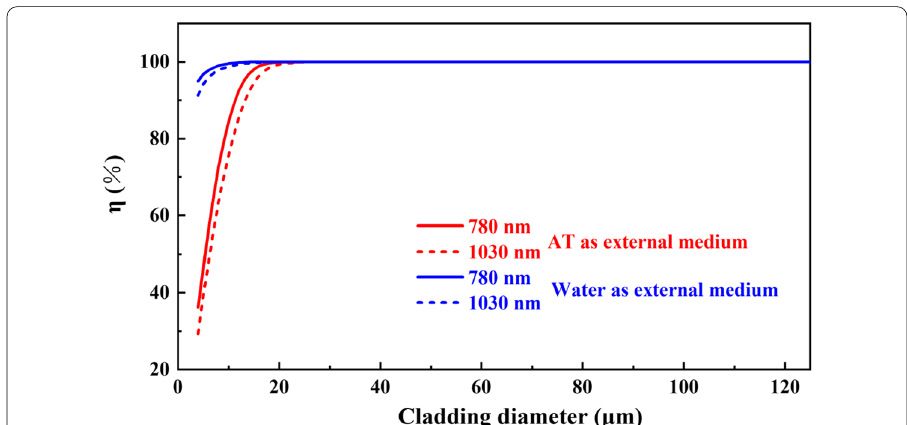
Fig.4 The calculated results of the fraction of optical power in the fiber η with 4 μm to125 μm cladding diameters. The blue line denotes that the external medium is water, and the red line denotes that the external medium is ATs. The η is 92.4% at 780 nm and 85.3% at 1030 nm when the cladding diameter is 12 μm and the external medium is